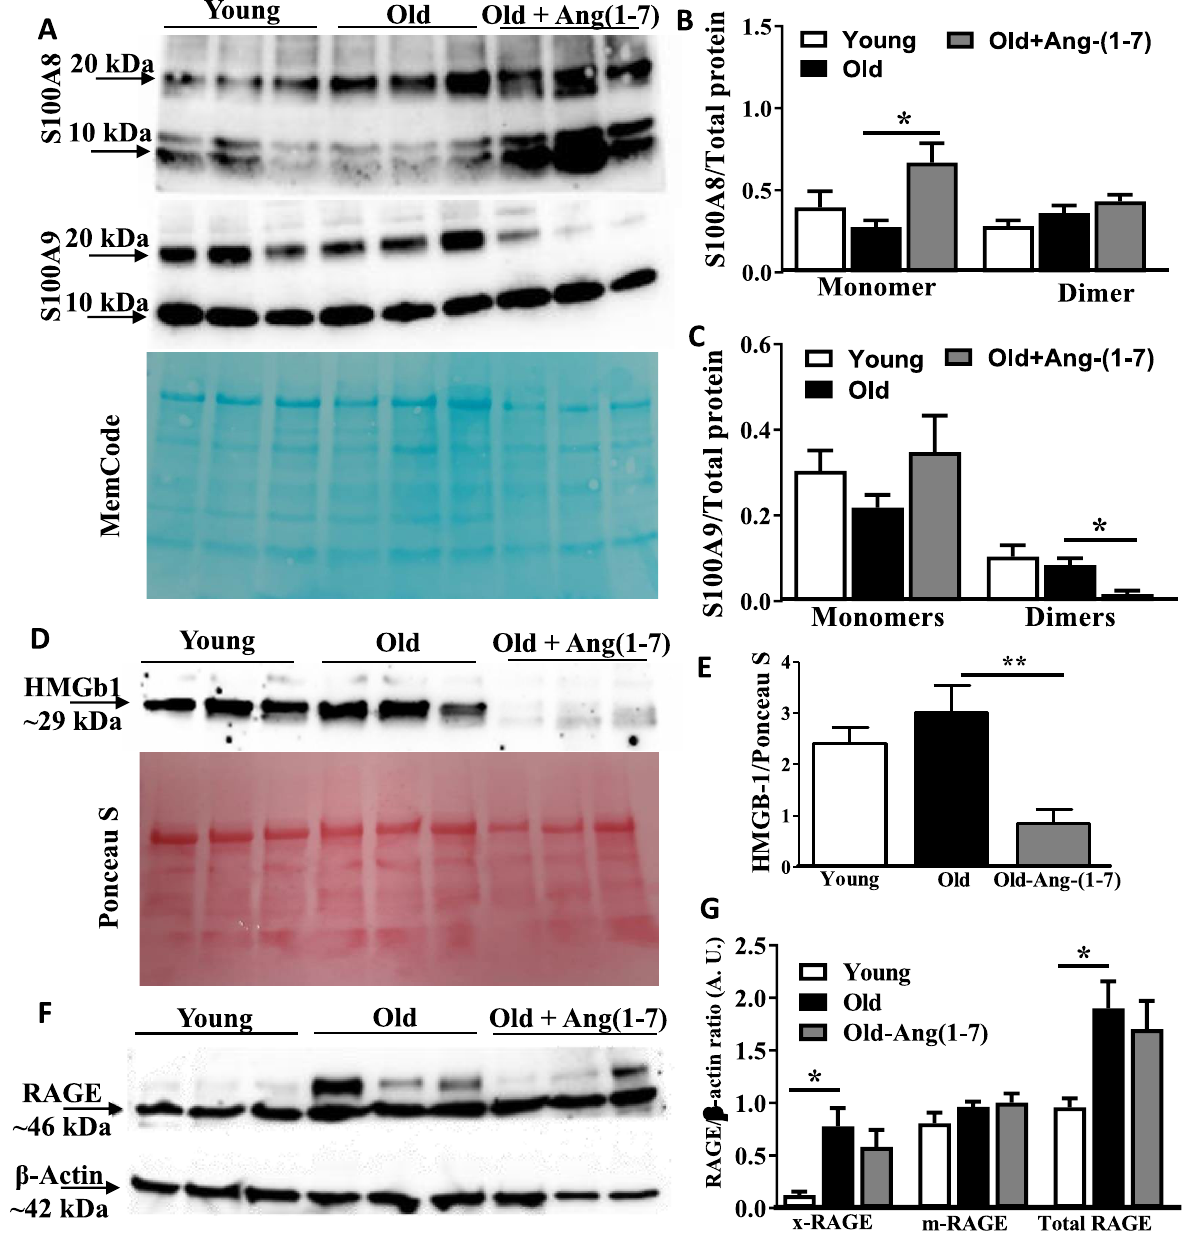
Figure 6. Protein levels of selected alarmins in the bone marrow supernatants derived from aging mice and the effect of Ang-(1–7): ( A ) representative western blots for S100A8 and S100A9 in the bone marrow supernatants from Young, Old and Ang-(1–7)-treated Old mice. Memcode was used to estimate the total protein. ( B ) S100A8 monomers were similar in Young and Old groups, Ang-(1–7) increased the levels in the Old compared to the untreated Old group (*P < 0.05, n = 6). No significant differences were observed in dimer levels. ( C ) S100A9 monomers were similar in all three groups. On the other hand, dimer levels were similar in the Young and Old but Ang-(1–7) decreased the dimer levels in the Old group (*P < 0.05, n = 6). ( D , E ) Representative western blots of HMGB1 in three different groups of bone marrow supernatants and Ponceau S was used for the estimation of total protein. HMGB1 levels were similar in Young and Old groups. Ang-(1–7) decreased the protein in the Old group (**P < 0.01, n = 6). ( F , G ) Representative western blots of RAGE in the bone marrow cells derived from three experimental groups with β-actin as an internal control. While the protein levels of mRAGE were similar in all three groups, xRAGE and total RAGE were higher in the Old bone marrow cells compared to the Young (*P < 0.05, n = 6). Ang-(1–7) has no effect on RAGE levels in Old group. One-way ANOVA was used for testing the statistical differences among experimental groups for comparing protein